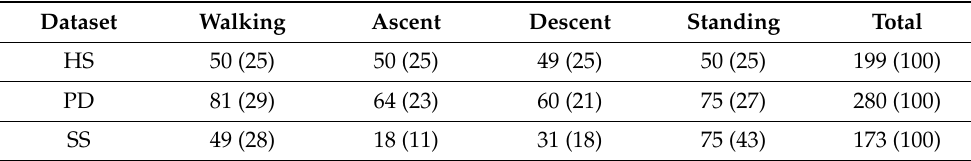
Table 1. Class distributions in local datasets (initial